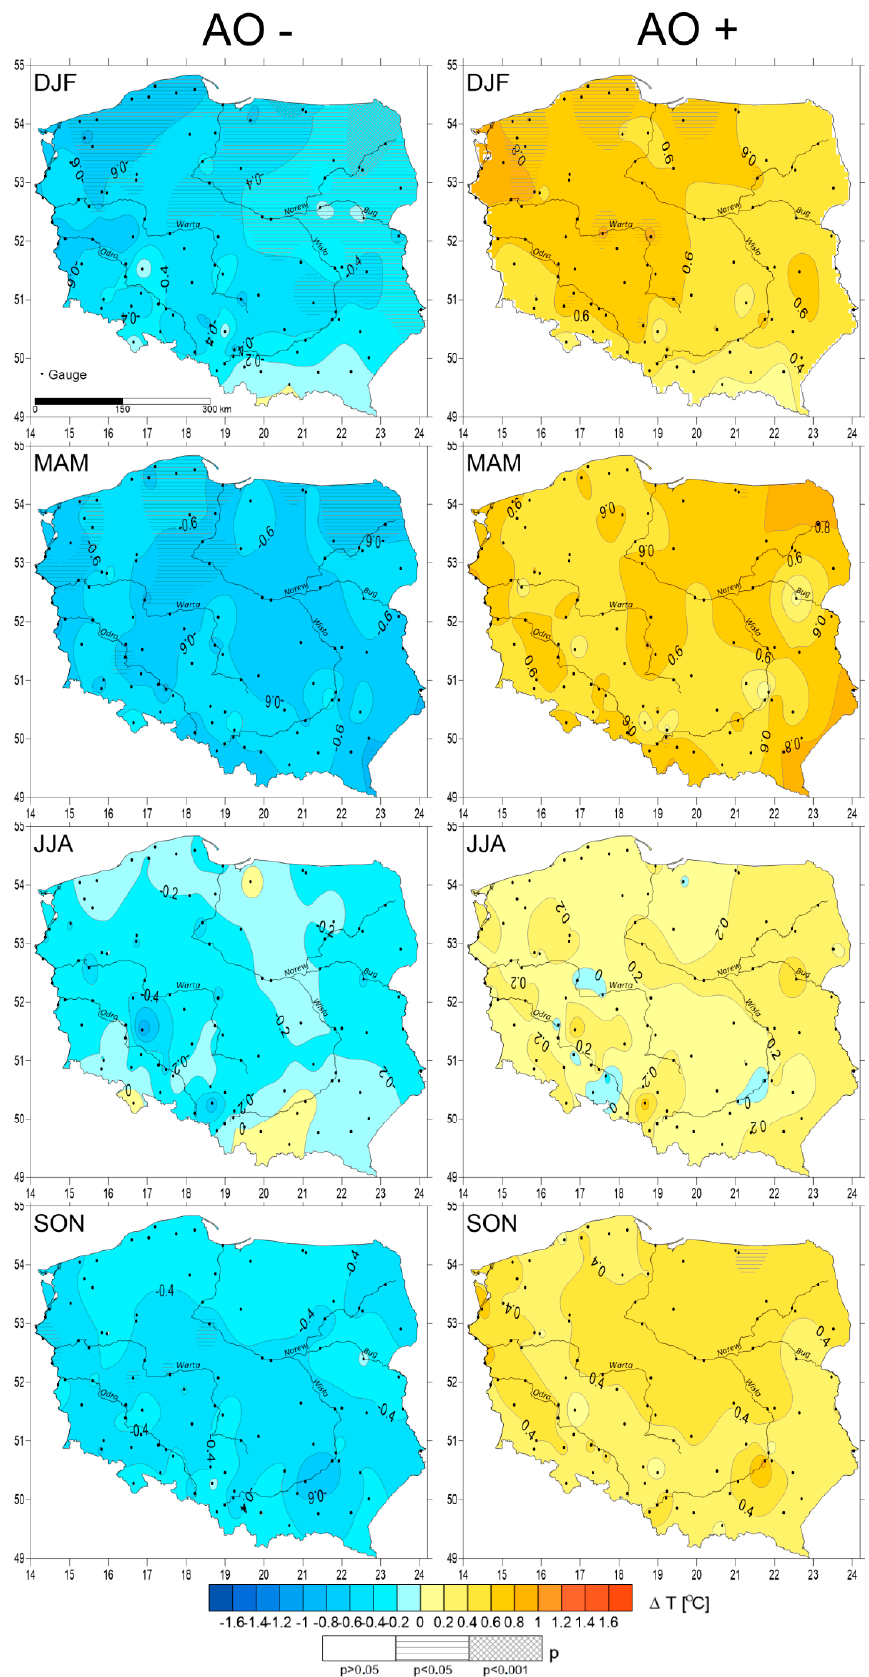
Figure 7. Spatial distribution of seasonal deviations of water temperature values ( ∆ T) in various AO phases from average values for the years 1971–2015 and their statistical significance (p).